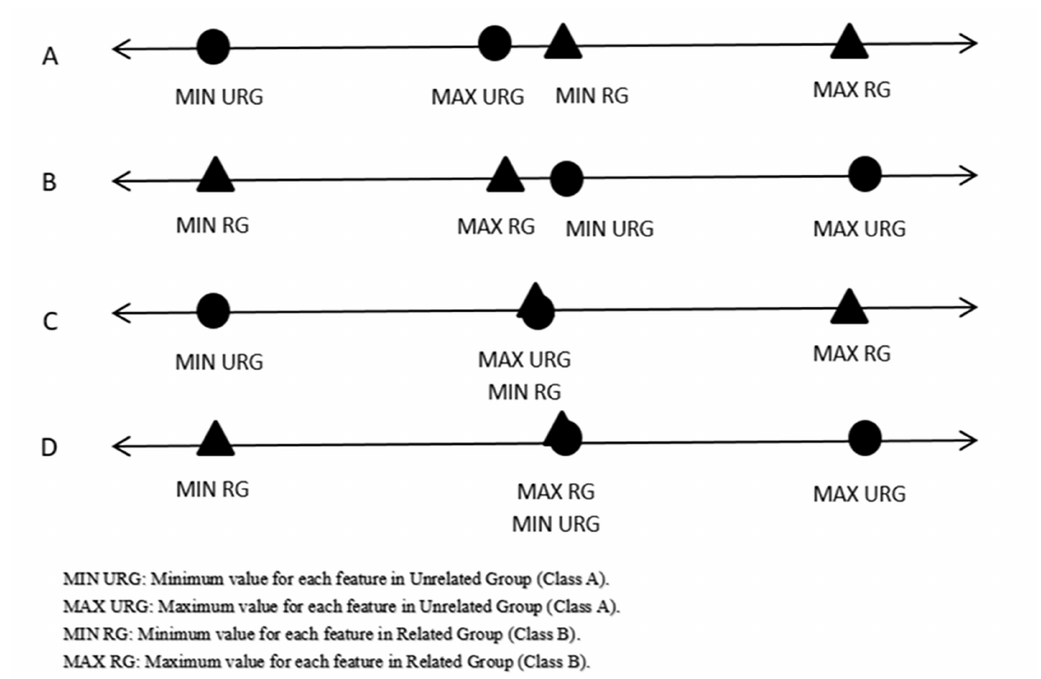
Figure 2. Ideal cases where there is no overlapping between the feature and the same feature in the corresponding class.